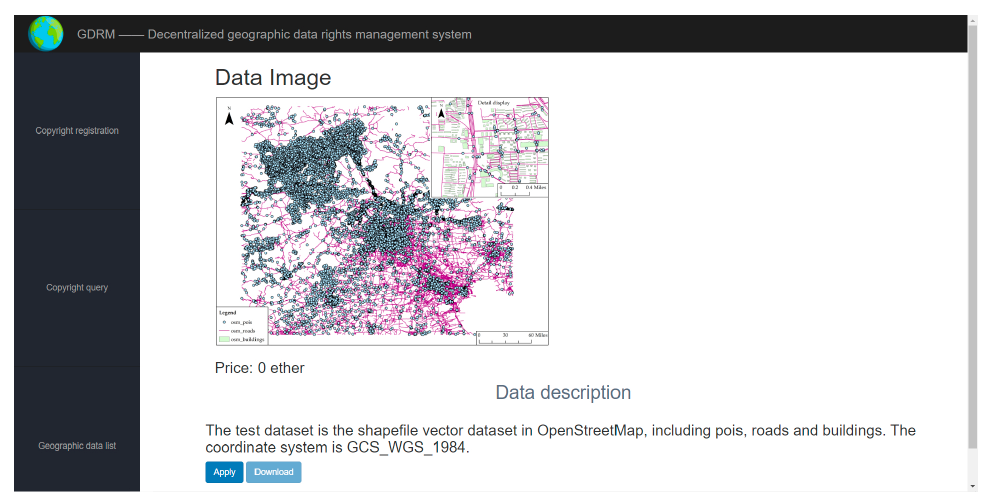
Figure 7. Spatial data use application interface.